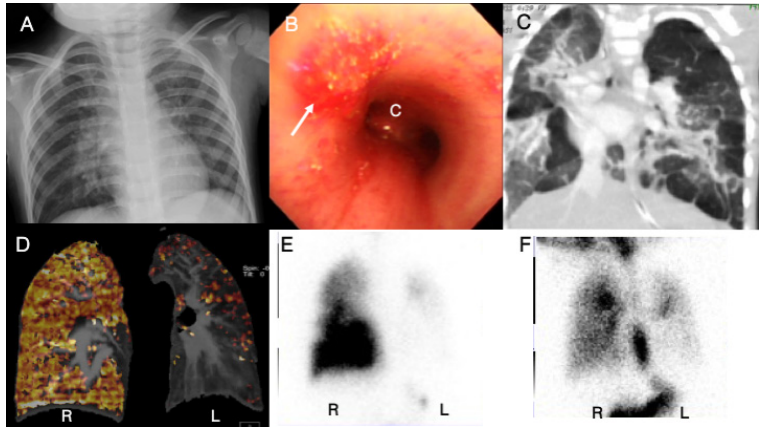
Figure 6. A 3-year-old boy presenting with hemoptysis and dyspnea was diagnosed with Swyer–